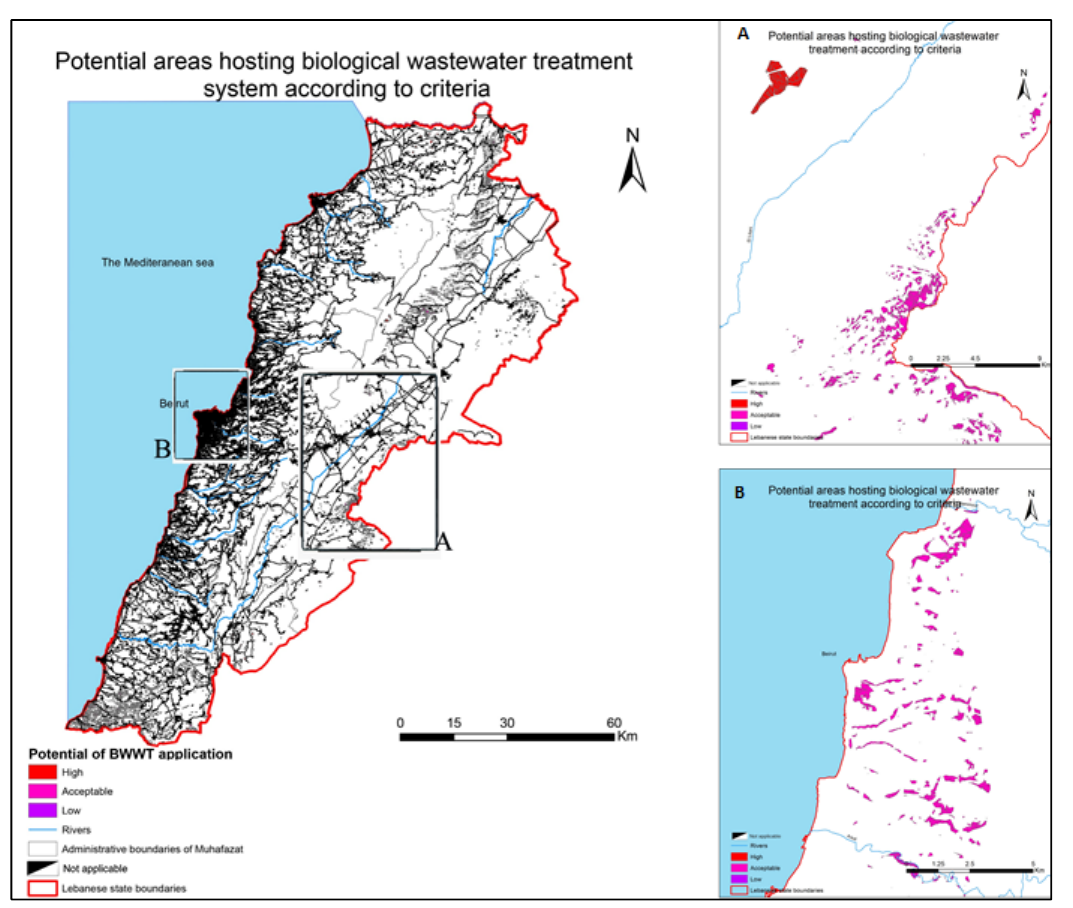
Figure 2. Potential areas hosting BWWT system in Lebanon based on fuzzy function of standardized spatial criteria. ( A ) Detail locations at eastern part of Lebanon, ( B ) Detail locations at Beirut region .